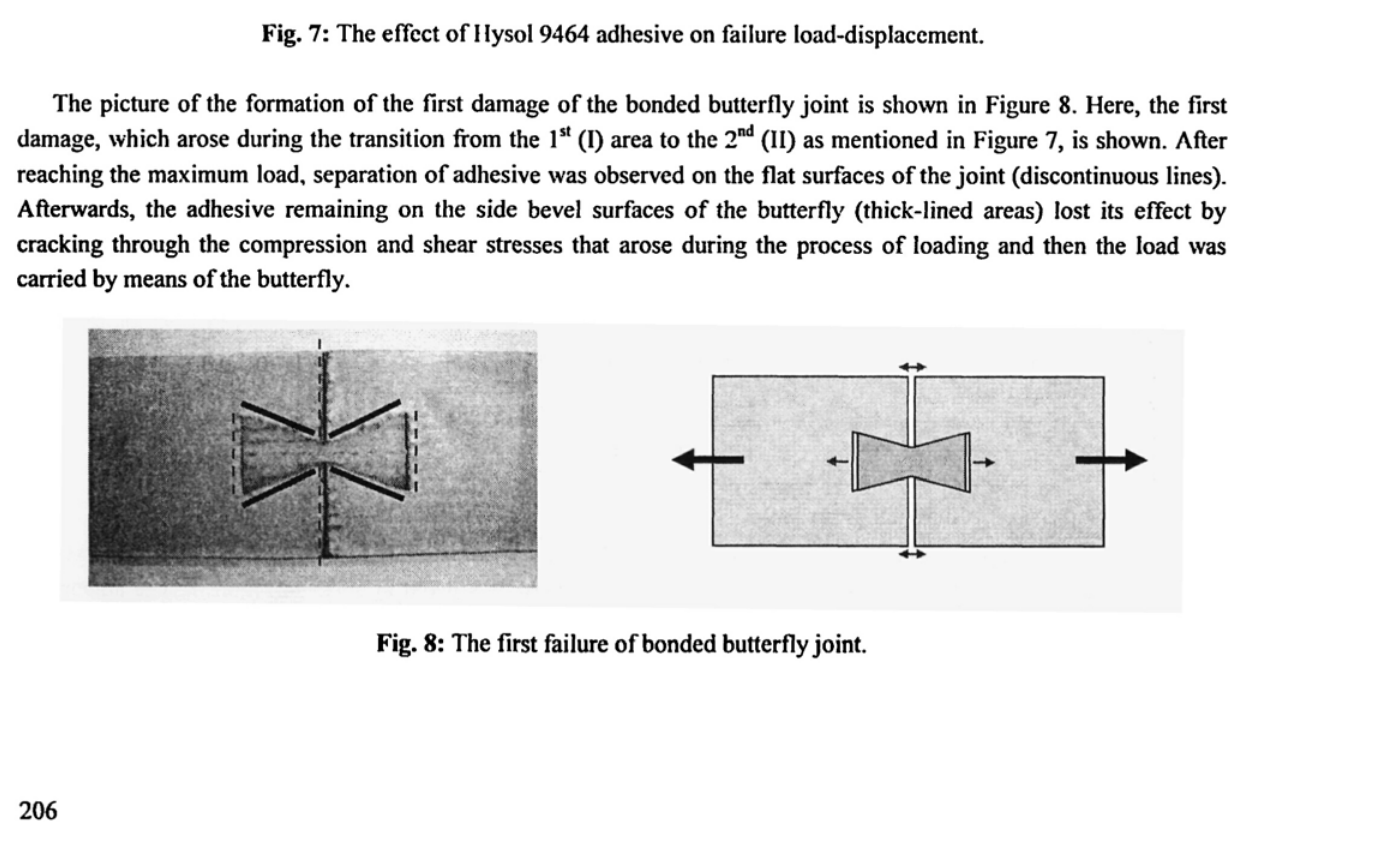
Fig. 8: The first failure of bonded butterfly